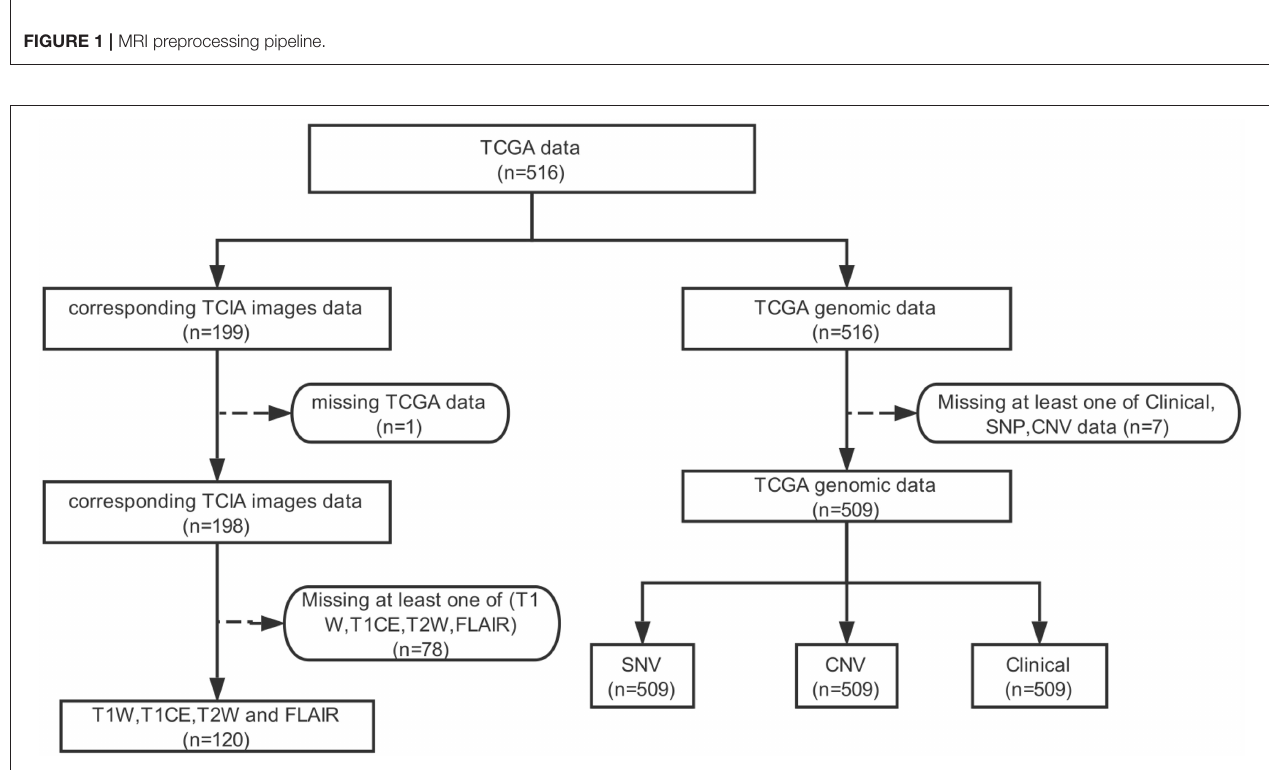
FIGURE 2 | Data screening